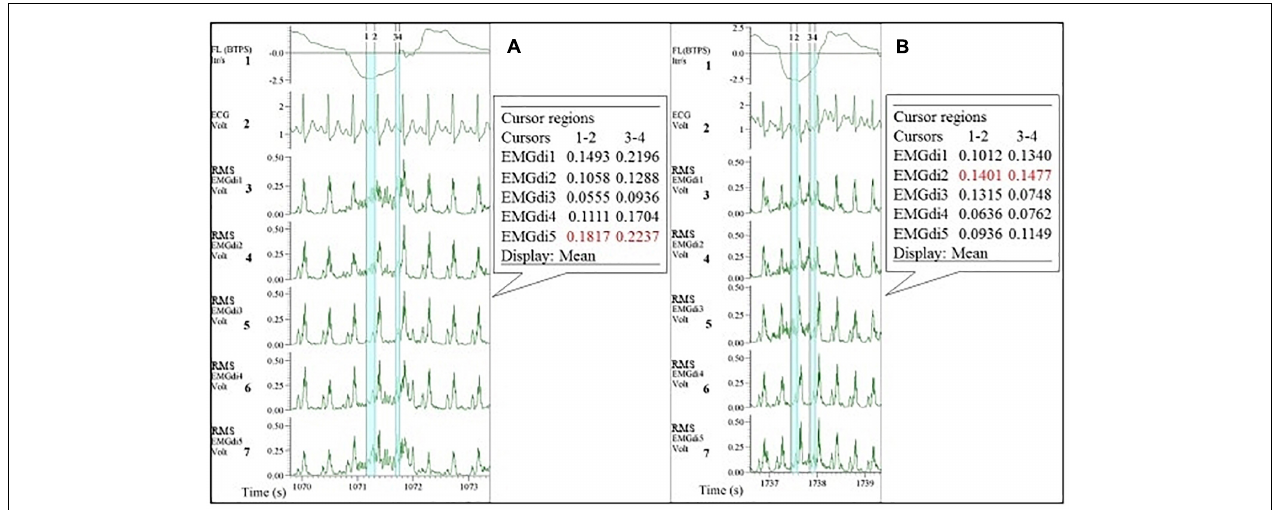
FIGURE 10 | Example of EMGdi recordings during cycling exercise toward the end of the (symptom limited) cycling test at the pre- (A) and post- (B) measurement for the analysis using the manual method. Channel 1: respiratory flow (l/s; negative flow indicating the inspiratory cycle), Channel 2: ECG recording (volt), Channels 3–7: diaphragm EMG (RMS EMGdi) recordings. The periods highlighted in light blue are the possible periods that could be chosen without ECG contamination in an inspiratory cycle. Numbers in cursors regions boxes show the mean EMGdi values between two vertical cursors. The numbers in red indicate that the differences in the mean values between cursors 1–2 are closer to the values between cursor 3–4 at